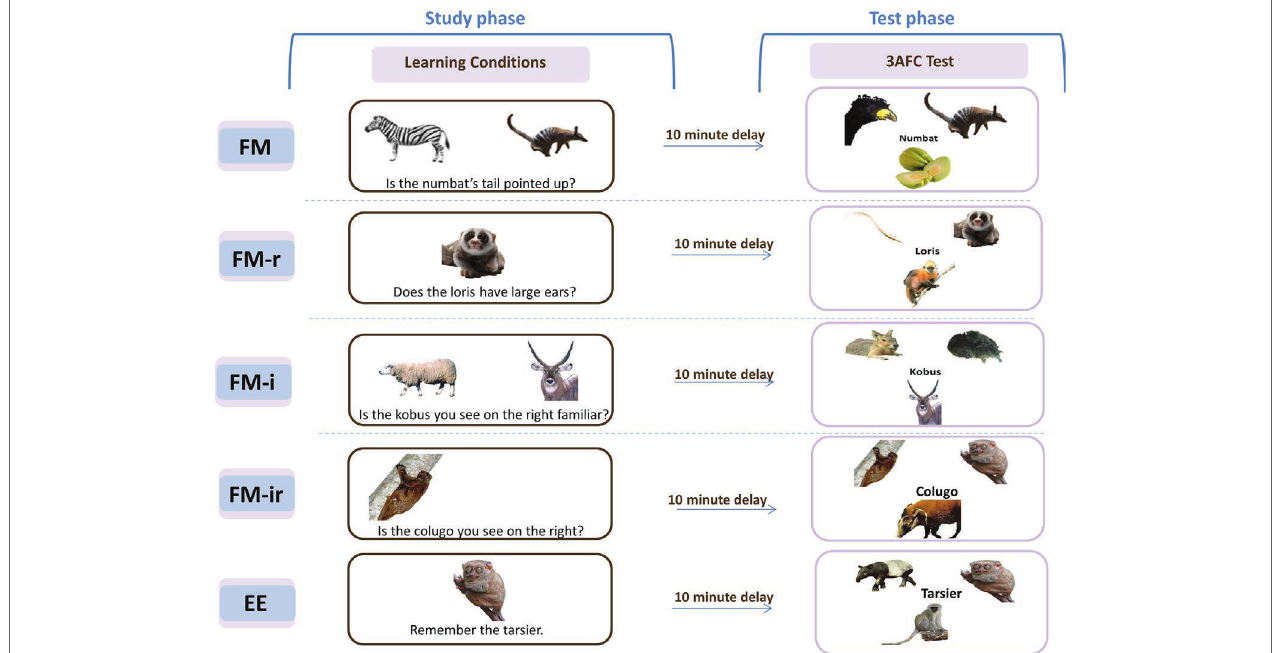
FIGURE 1 | Original fast mapping (FM) procedure, FM variants, and explicit encoding (EE) conditions. Five conditions were implemented across four experiments. Experiments 1–3 tested three of these conditions, in separate study-test blocks, in within-participant designs. Experiment 4 tested all five conditions in a between- participant design. Experiment 1 used conditions FM, FM-r, and FM-ir; Experiment 2 was FM, FM-i, and FM-ir; Experiment 3 replicated the conditions and methods of Experiment 2, but in a healthy older group; Experiment 4 implemented FM, FM-r, FM-i, FM-ir, and EE in between-participants in young groups. For additional information on learning conditions, see main text. In the study phase for FM variants, names were to be incidentally associated with the unknown picture. Key prompts for “yes”/“no” were displayed at the bottom of the screen, on respective sides, but are omitted from this figure for simplicity. In the EE condition (administered in Experiment 4 only), participants were instructed to learn. The test phase, which was methodologically identical in all experiments and conditions, explicitly tested memory in a 3 Alternative Force Choice (3AFC) test. Study and test phases were separated by a 6 – 10 min nonverbal task. In Experiments 1–3, presentation order of learning condition and stimuli set-to-condition assignment was counterbalanced across participants within each